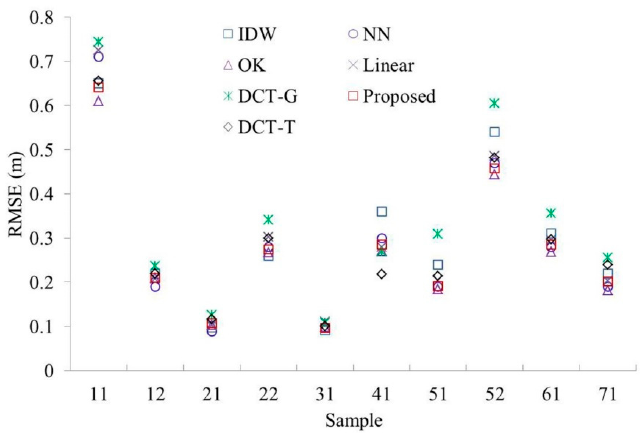
Figure 6. Accuracy comparison between the proposed method and the other interpolation methods